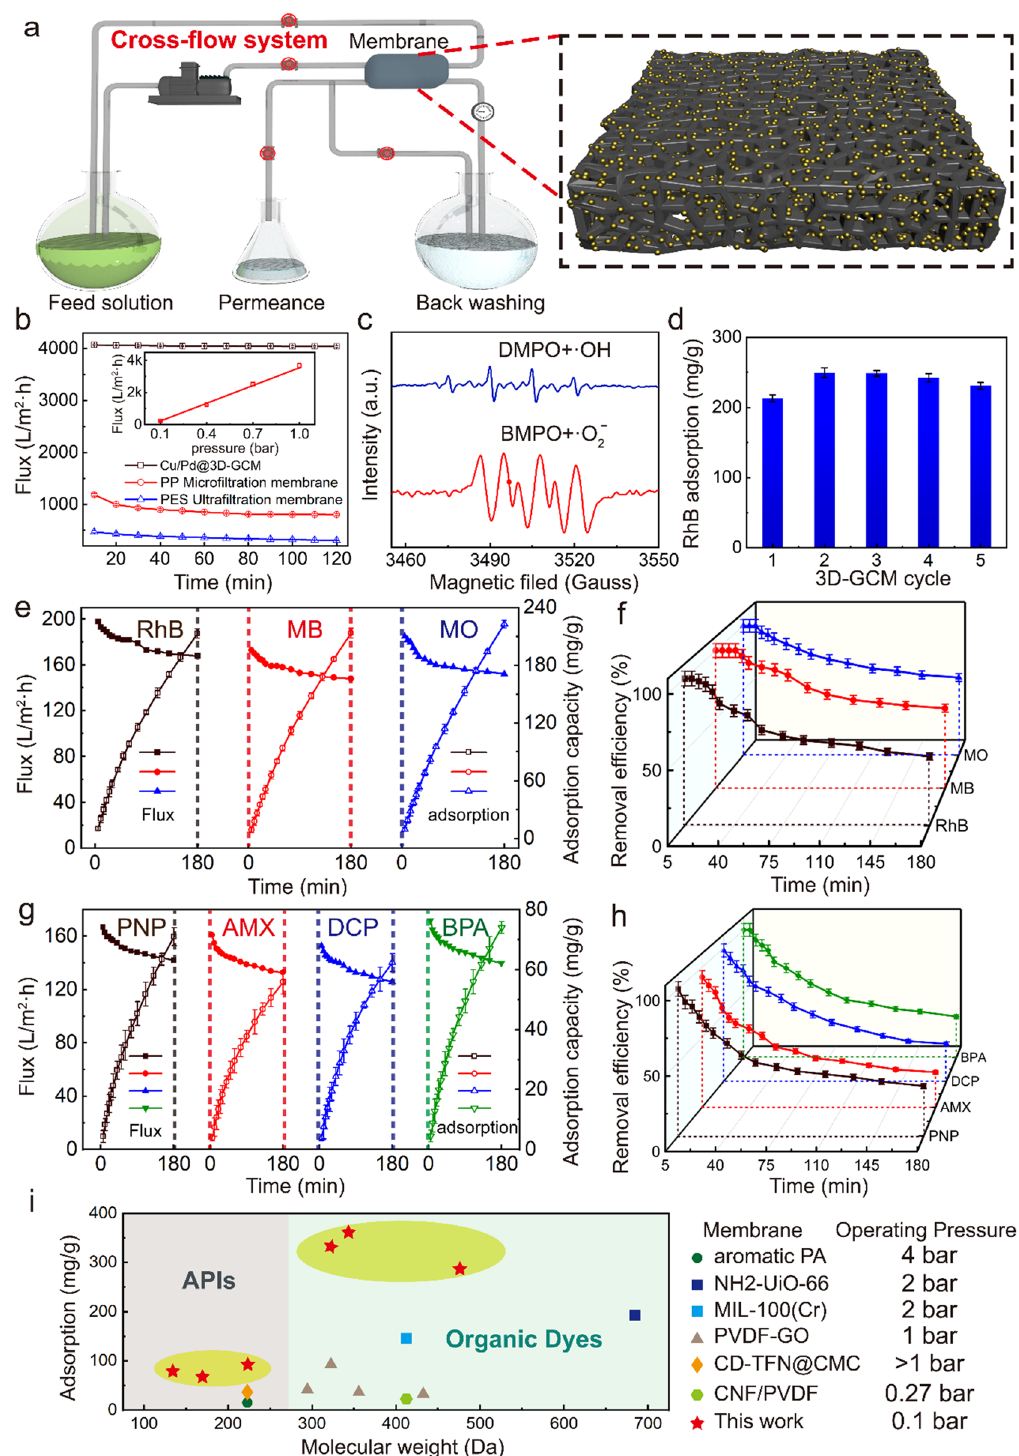
Fig. 2 a Schematic diagram of the cross‑flow system, inset: schematic illustration of the catalytic membrane loaded with MNPs. b Water fluxes of Cu/Pd@3D‑GCM (black), PP microfiltration (red), and PES ultrafiltration membrane (blue). Inset: relationship between pure water flux and driv‑ ing pressure for Cu/Pd@3D‑GCM. c EPR spectra of DMPO/·OH adducts and BMPO/·O 2− adducts over 3D‑GCM. d The adsorption capacity for RhB of the Cu/Pd@3D‑GCM in the presence of H 2 O 2 after consecutive regeneration cycles. e–h Time‑dependent Flux, adsorption capacity, and removal efficiency of each pollutant by Cu/Pd@3D‑GCM. i Performance comparison of 3D‑GCM with other membranes reported in